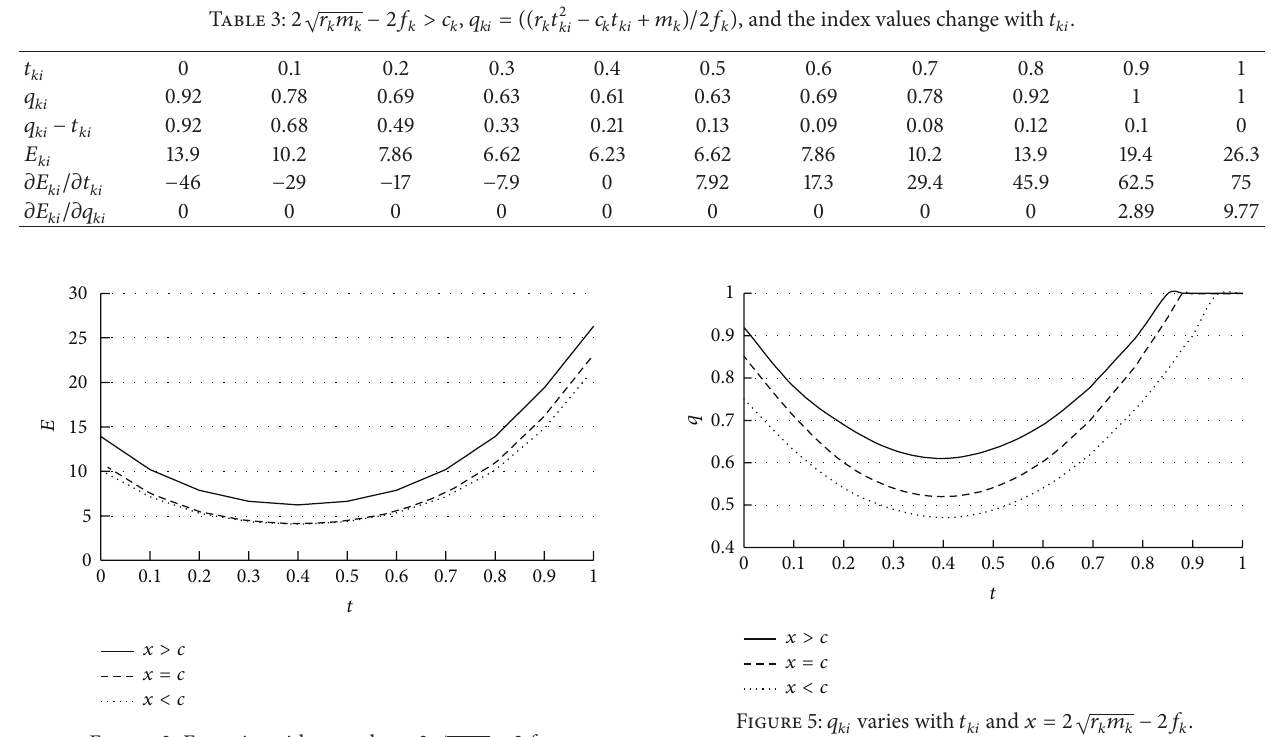
Figure 3: 𝐸 𝑘𝑖 varies with 𝑡 𝑘𝑖 and 𝑥 = 2√𝑟 𝑘 𝑚 𝑘 − 2𝑓 𝑘 .